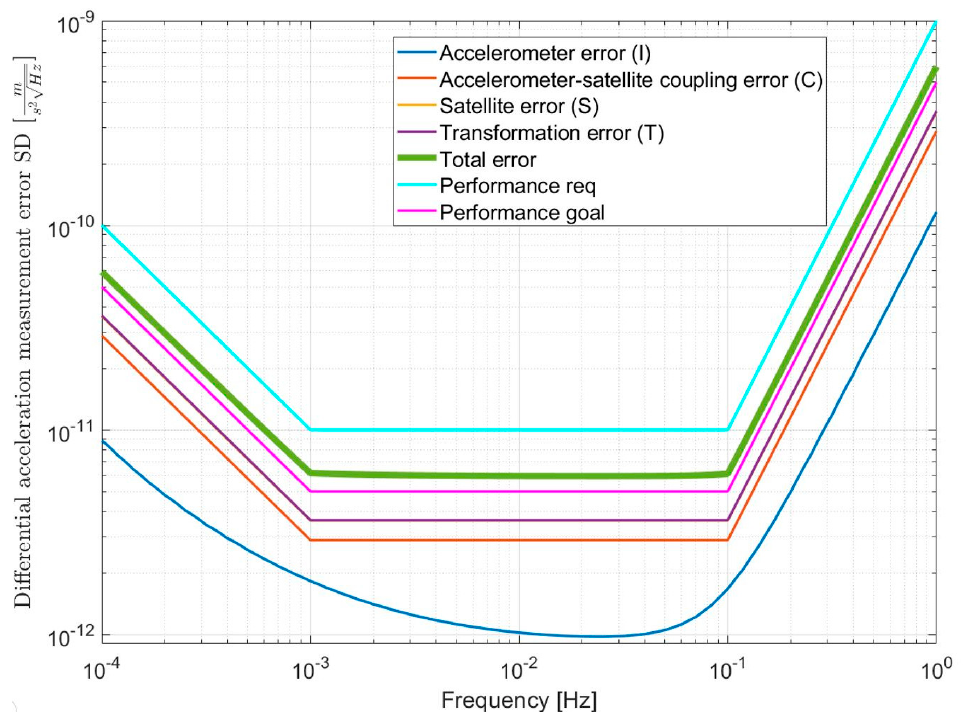
Figure 17. Nominal non-gravitational acceleration measurement performance (green line) in the case of perfect matching of control requirements (see Section 3.3) and realistic conservative allocations for the values of the parameters subject to calibration (see Section 3.1), in comparison to mission performance requirements (light blue) and goals (magenta). Shown in dark blue, red, yellow, and purple are the (I), (C), (S), and (T) uncertainty contributors to the overall budgeted performance, respectively.